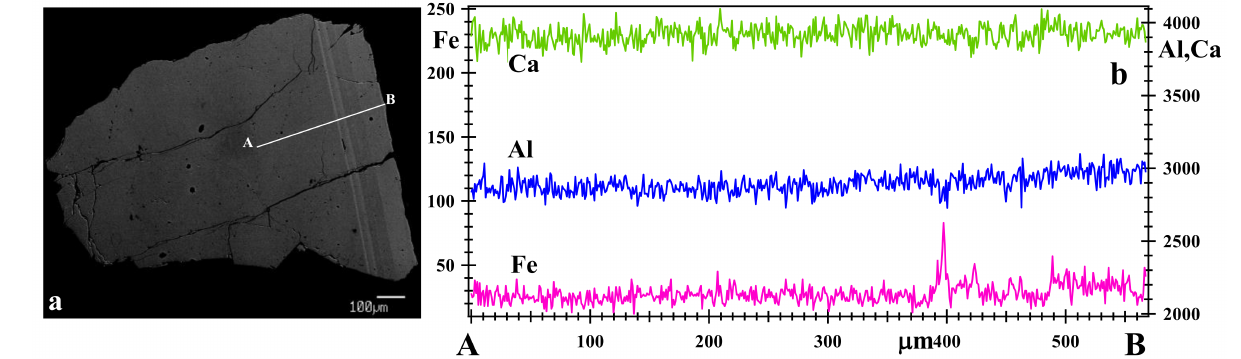
Figure 5. Backscattered electron (BSE) image ( a ) for a birefringent grossular sample-3 from Coahuila, Mexico, that corresponds to that in Figure 3a,b. This sample-3 contains two phases that have different contrast. The light bands and lines are parallel to the right edge of the crystal. A line scan along the line A to B in ( a ) is displayed in ( b ) and shows the inverse compositional variations in Al 3+ and Fe 3+ cations, whereas the Ca content is constant. The scale bar in ( a ) represents 100 µ m. The line scan units are arbitrary.